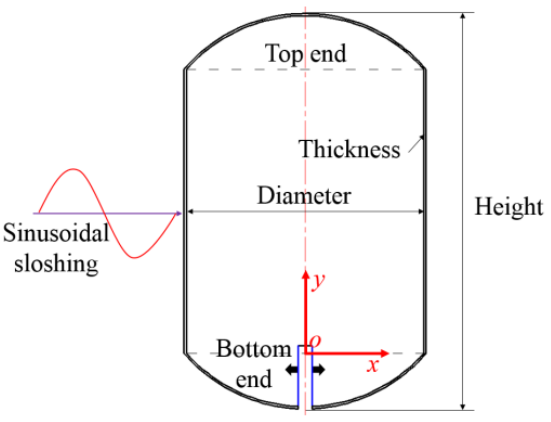
Figure 2. Application of sinusoidal sloshing.